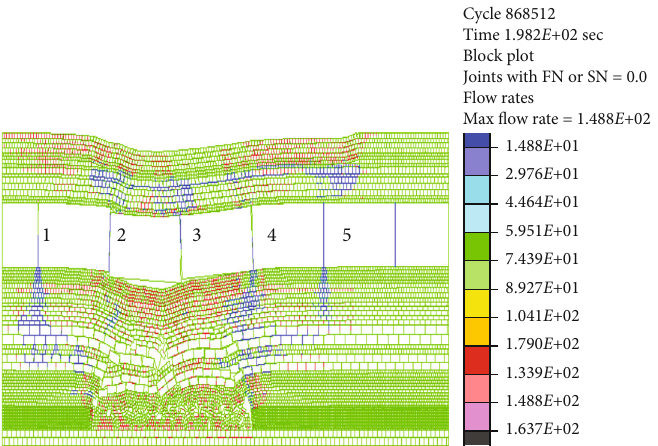
Figure 13: The fl ow distribution in initial caving of key layer